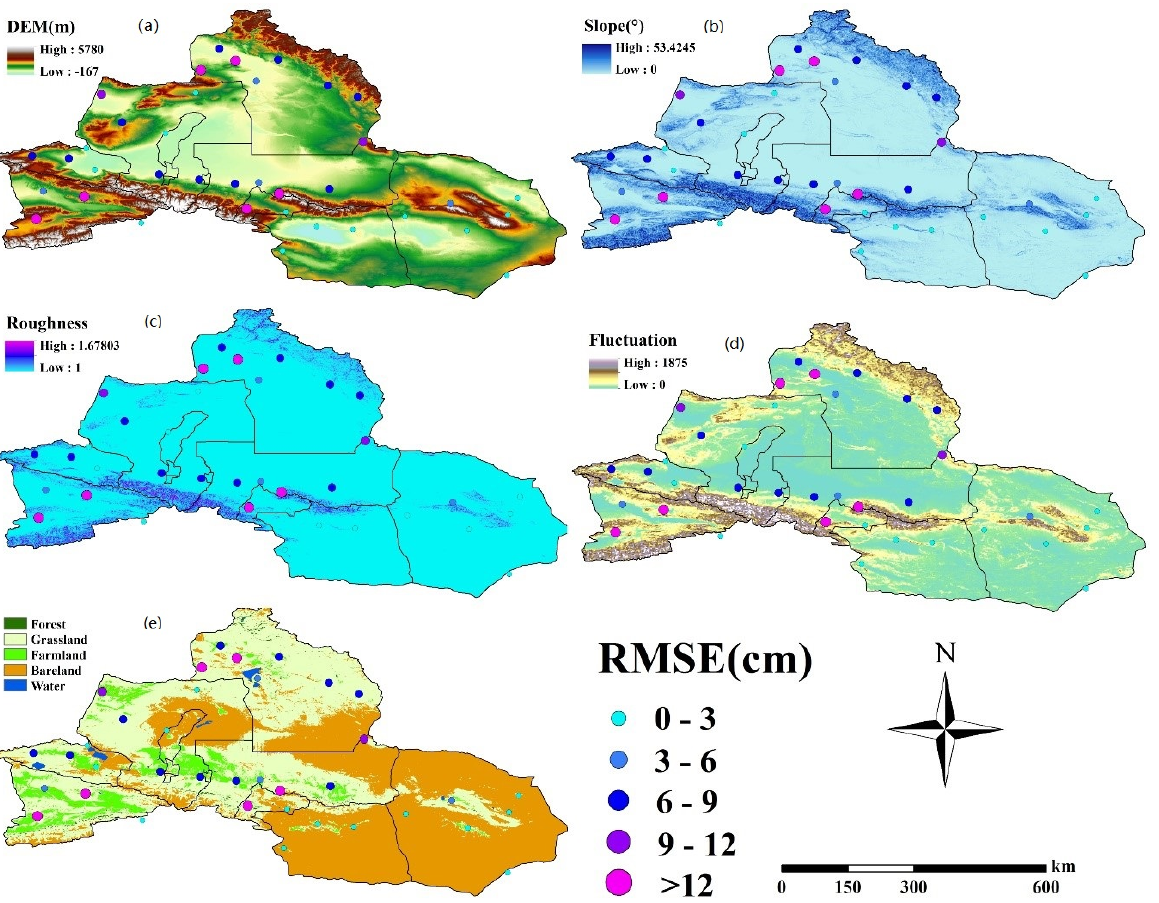
Figure 11. RMSE of downscaled SD at different terrains. DEM ( a ), Slope ( b ), Roughness ( c ), Fluctuation ( d ) and Land cover ( e ).